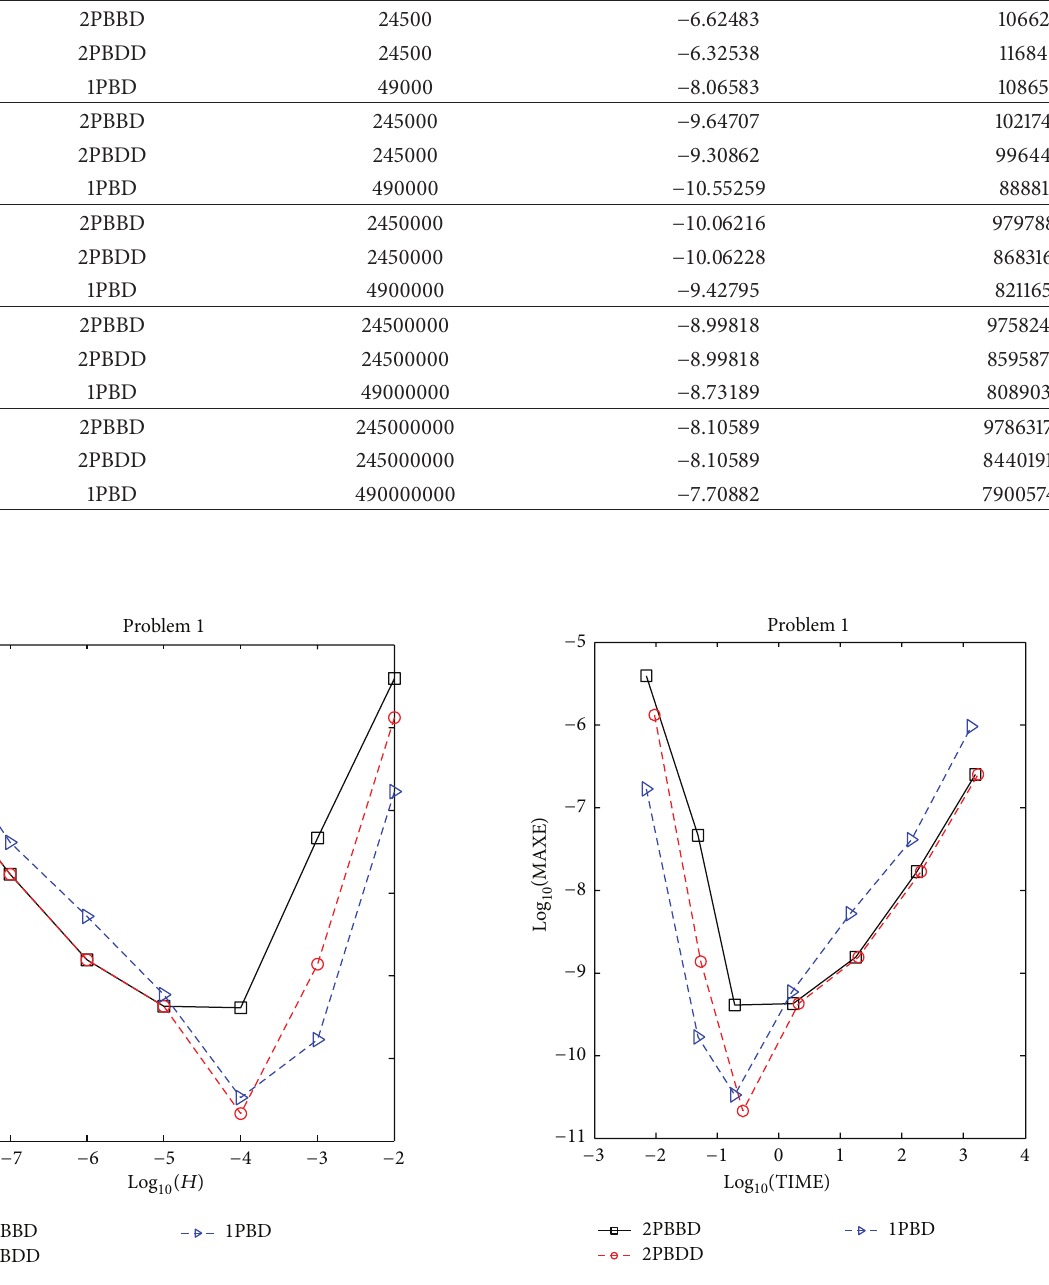
Figure 3: Graph of Log 10 ( MAXE ) plotted against Log 10 ( TIME ) for Problem